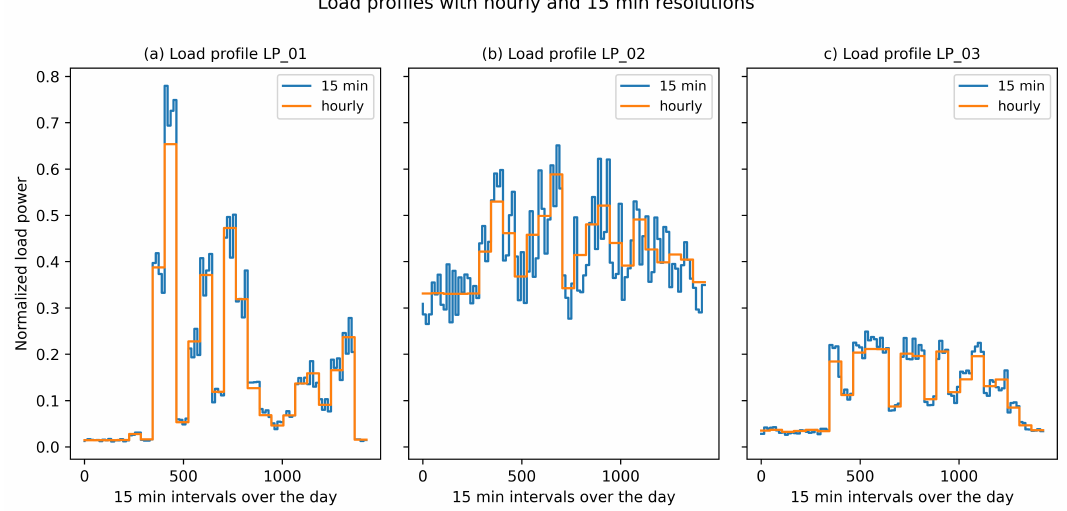
Figure 14. Load profiles with 15 min resolution generated (according to (3)) from hourly resolution (for example, for the first day in a year): ( a ) LP 01; ( b ) LP 02; ( c ) LP 03.